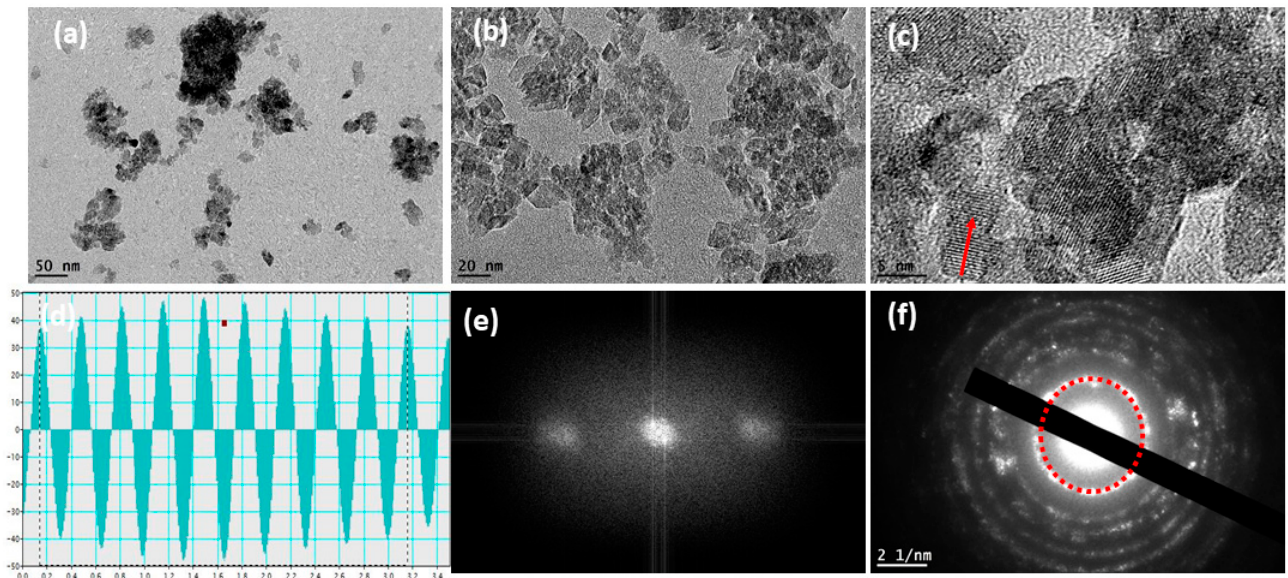
Figure 1. ( a , b ) TEM images, ( c ) HRTEM image, red arrow represents the direction of (101) crystal plane, and ( d – f ) SAED pattern of the 5 nm TiO 2 nanoparticles.